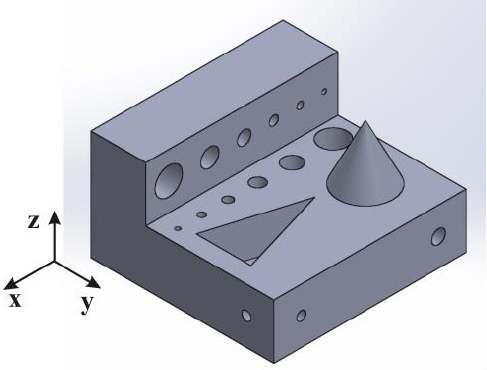
Figure 2. 3D Computer aided design (CAD) model of test plate.